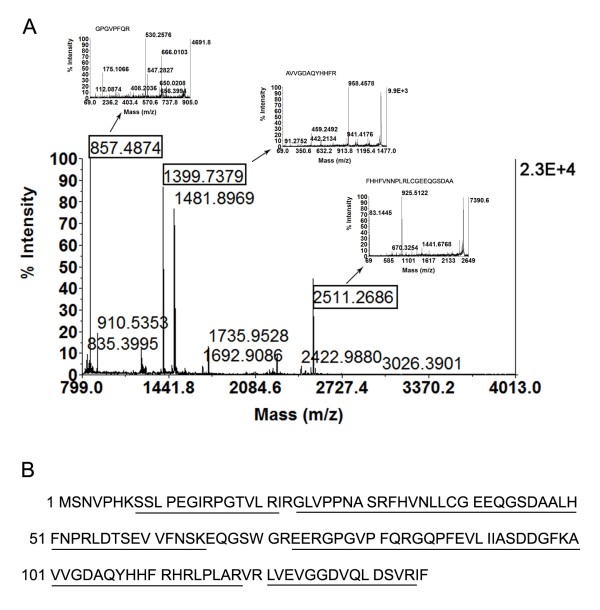
Identification of galectin-7 by MALDI-TOF/TOF mass spectrometry. (A) Peptide mass fingerprints of galectin-7 are shown. Matched peptide peaks are labeled with mass values, and the sequences of precursor peptides with m/z 857.4628, 1399.7379 and 2511.1833 were confirmed using MALDI-TOF MS/MS. (B) Amino acid sequences of galectin-7. Matched peptides are underlined.